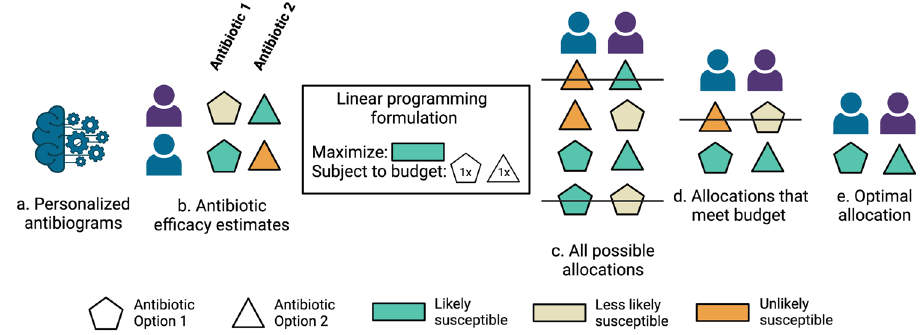
Fig. 2 Optimizing antibiotic selections with linear programming. Patient feature vectors are ingested by personalized antibiogram models ( a ) to produce antibiotic ef fi cacy estimates ( b ). Each patient in the test set receives a predicted probability of ef fi cacy for each antibiotic. In this illustration, pentagons refer to one antibiotic option and triangles refer to another. Green indicates the antibiotic option is likely to cover the patient, orange indicates the antibiotic is unlikely to cover the patient. A linear programming objective function is speci fi ed with a set of constraints that limit how frequently certain antibiotics can be used. Here the objective function speci fi es to maximize the total predicted antibiotic ef fi cacy (green) across the two patients subject to the constraint that each antibiotic option is only used once. c Depicts all possible antibiotic allocations color coded by patient speci fi c antibiotic ef fi cacy estimates produced by personalized antibiograms. Antibiotics allocations are only considered ( d ) if they meet the constraints of the linear programming formulation. The antibiotic allocation that maximizes the total predicted ef fi cacy across the set of patients ( e )